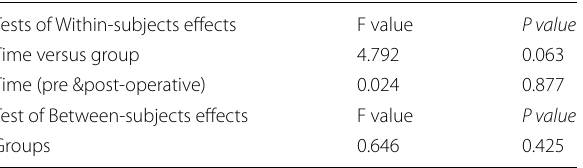
Table 3 The effect of the BII and the SSI approaches on the mean peri‑operative s. K